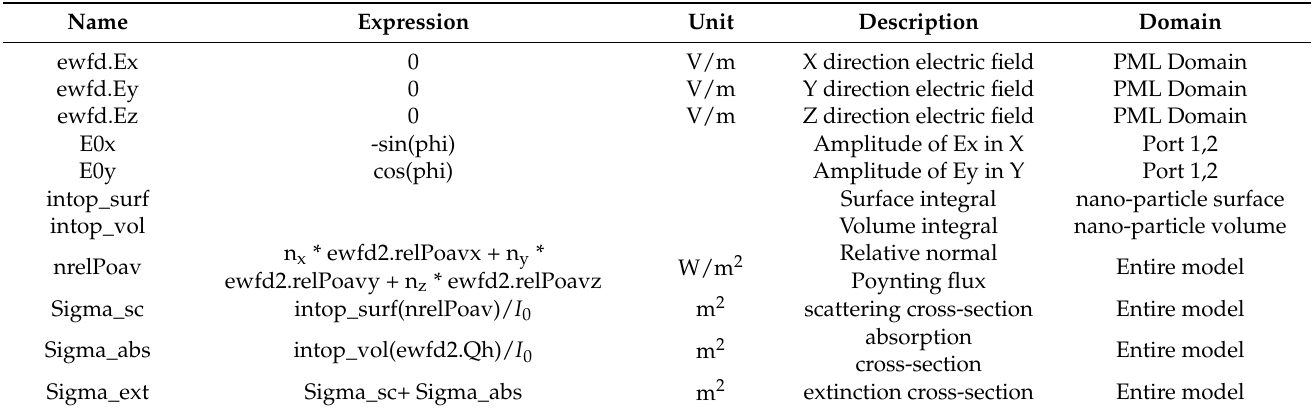
Table 2. Variables and functions used during the